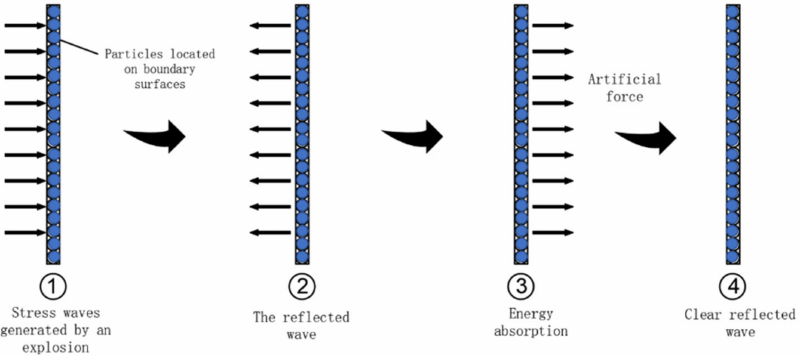
Figure 4. Transmission boundary